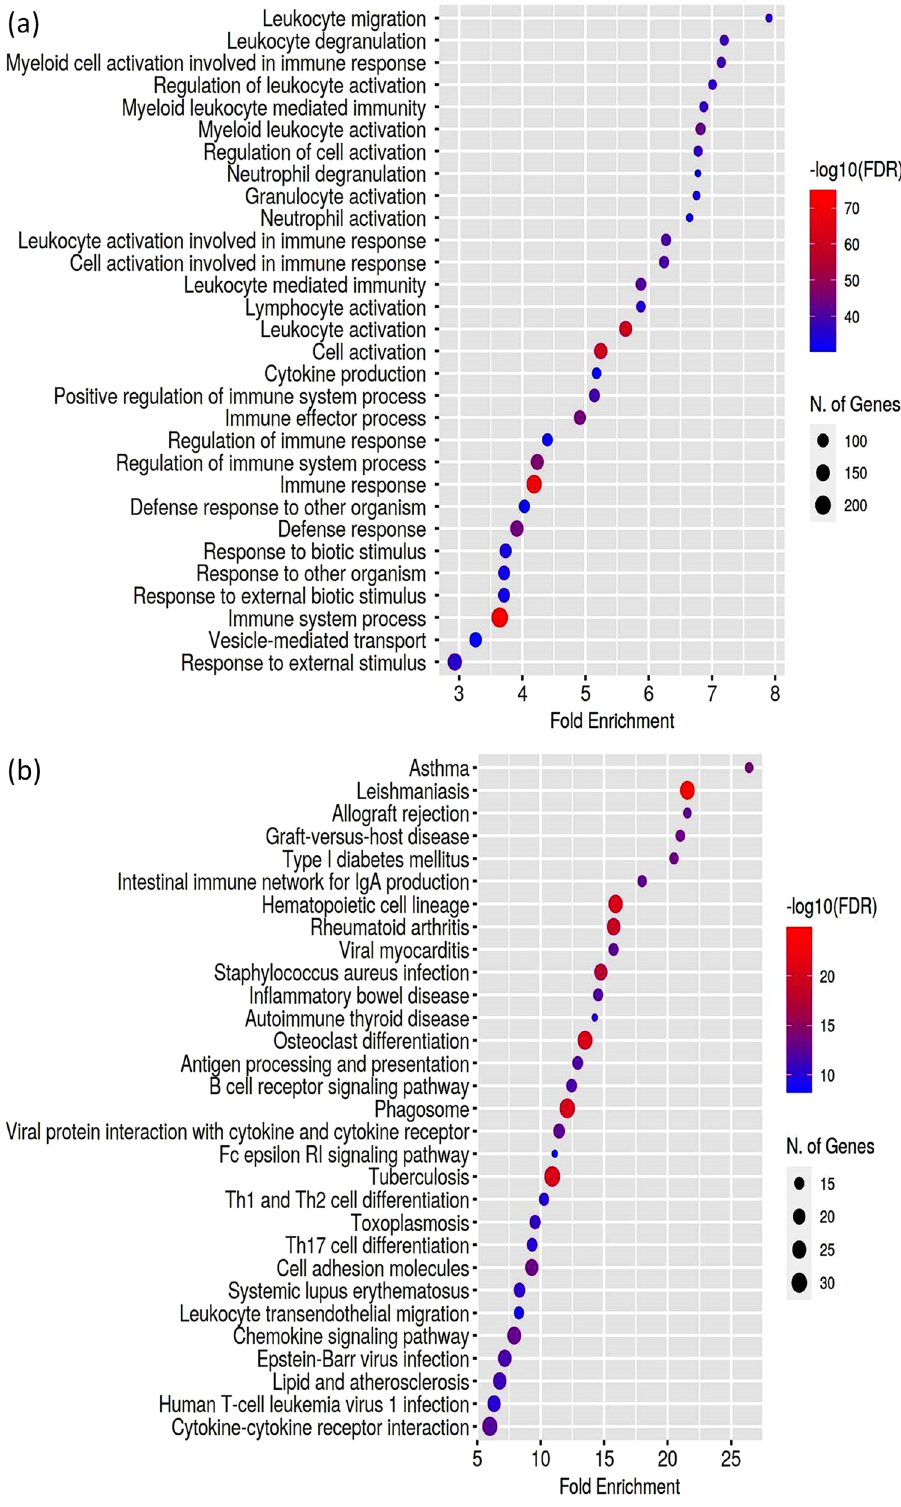
Figure 5: GO enrichment analysis by biological processes ( a ) and KEGG pathways ( b ) for common upregulated DEGs from data set GSE100927. Biological processes and KEGG pathways are ranked according to the fold enrichment values. The most signi fi cant processes and KEGG pathways are highlighted in red, and the less signi fi cant processes are highlighted in blue according to log10 ( FDR ) values. Larger dots in the graph indicate a greater number of genes